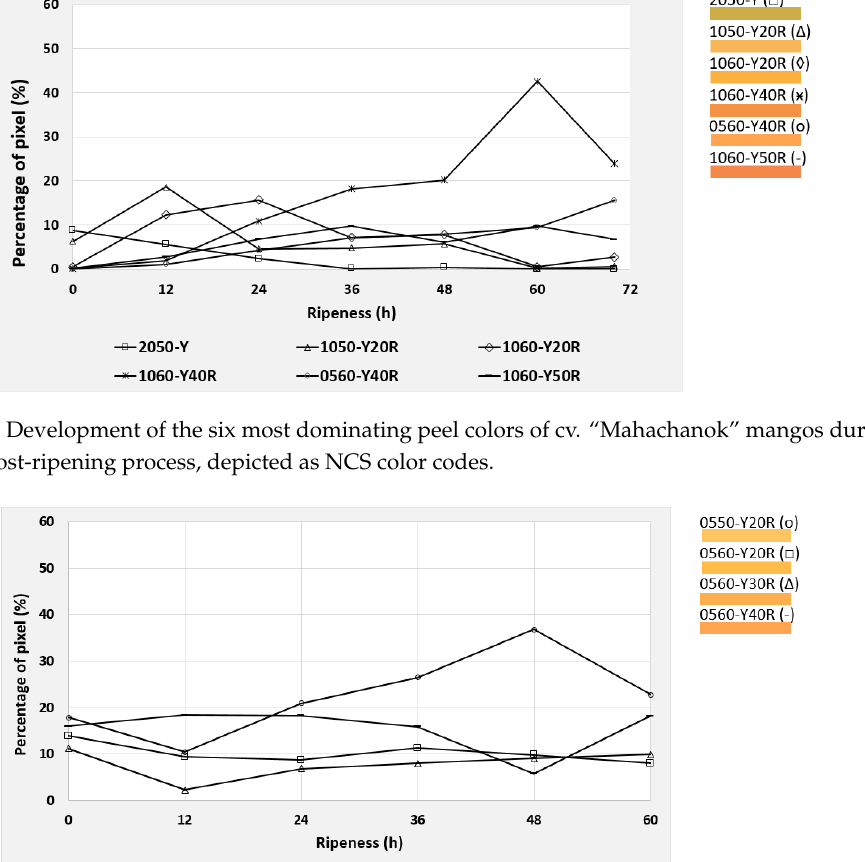
Figure 14. Development of the four most dominating pulp colors of cv. “ Kent ” mangos during the 70 h post-ripening process, depicted as NCS color codes.